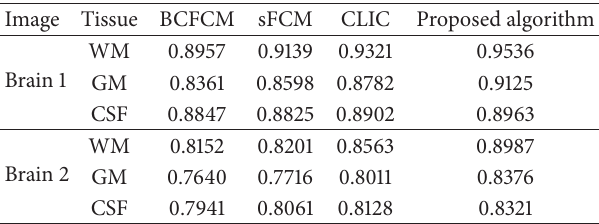
Table 1: Comparison of the JS values of the segmentation results obtained by the four